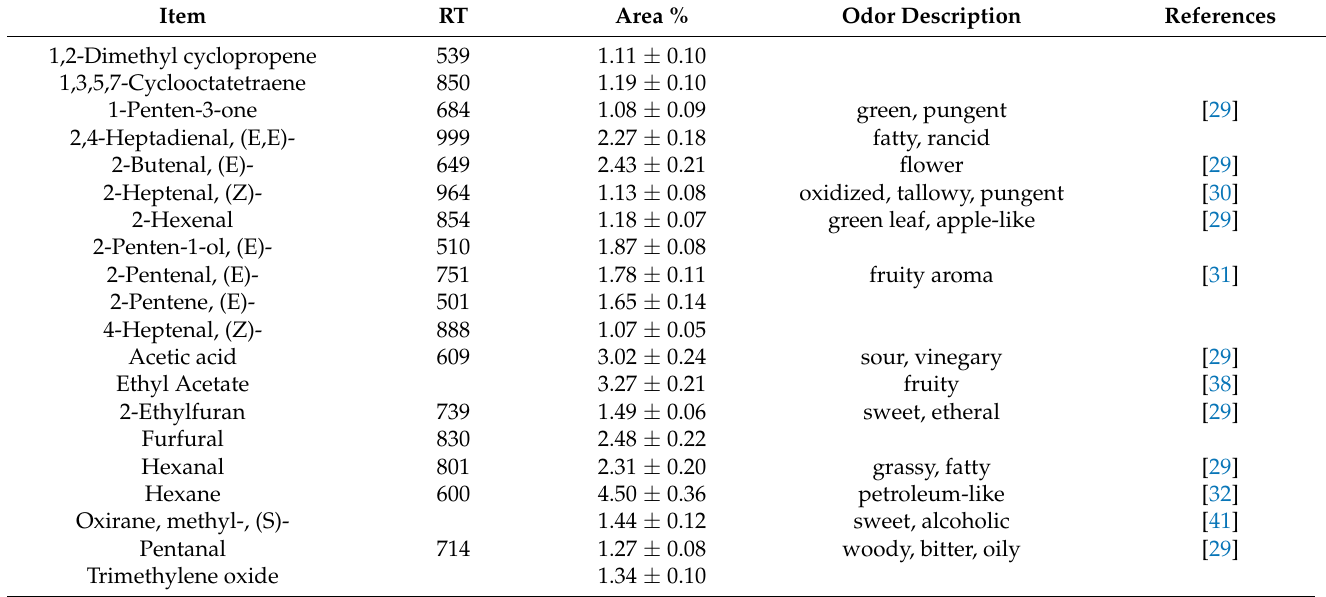
Table 7. Percentage composition of volatile compounds from cranberry seed oil obtained by sonification.